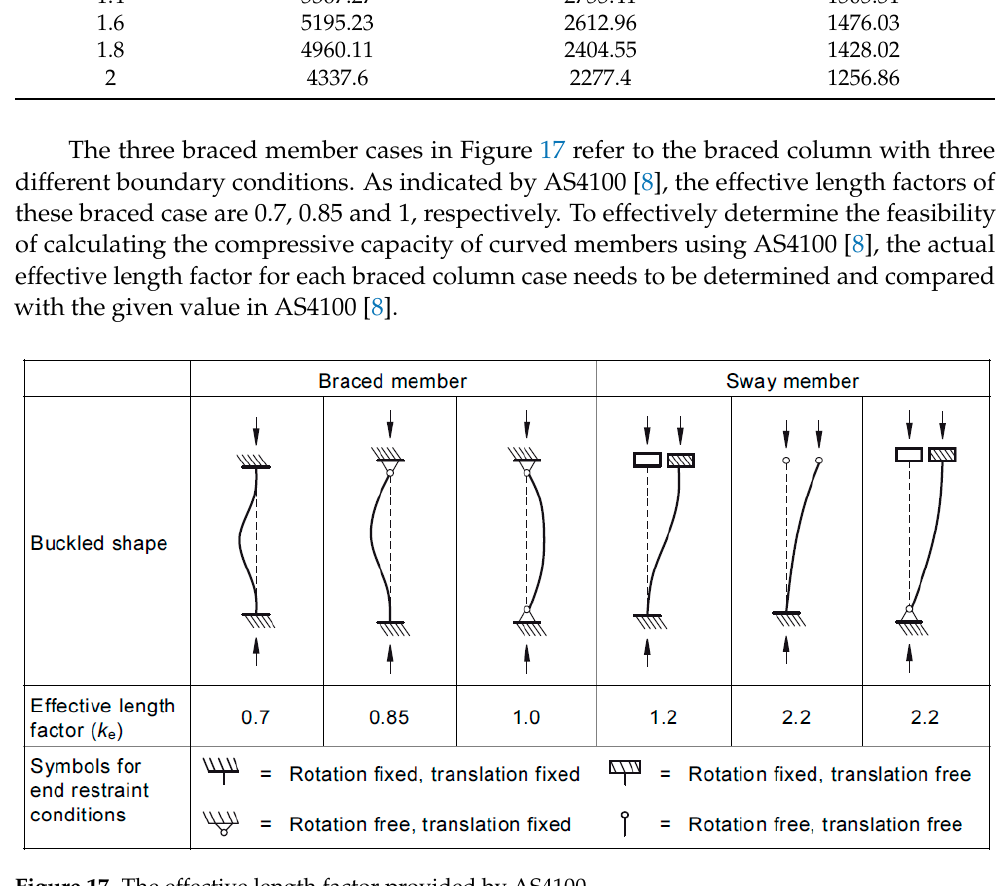
Figure 17. The effective length factor provided by